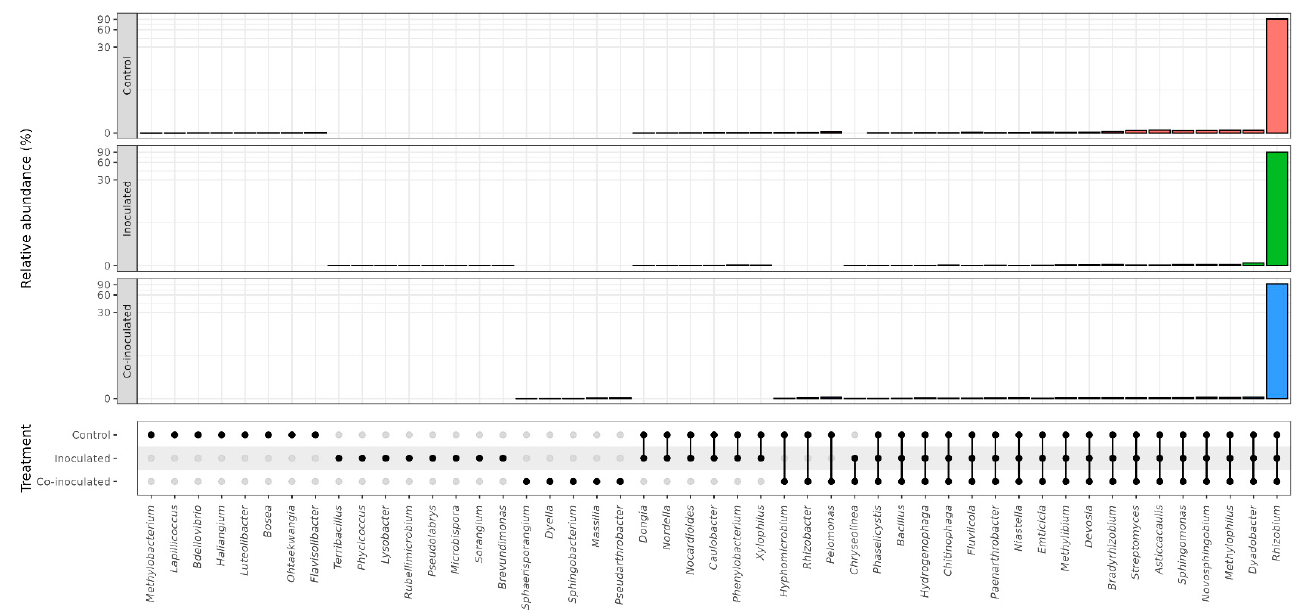
Figure 5. Genera of bacteria in the microbiomes of common bean nodules in the treatments (i) non-inoculated (control); (ii) inoculated with Rhizobium tropici ; and (iii) co-inoculated with R. tropici and Azospirillum brasilense .